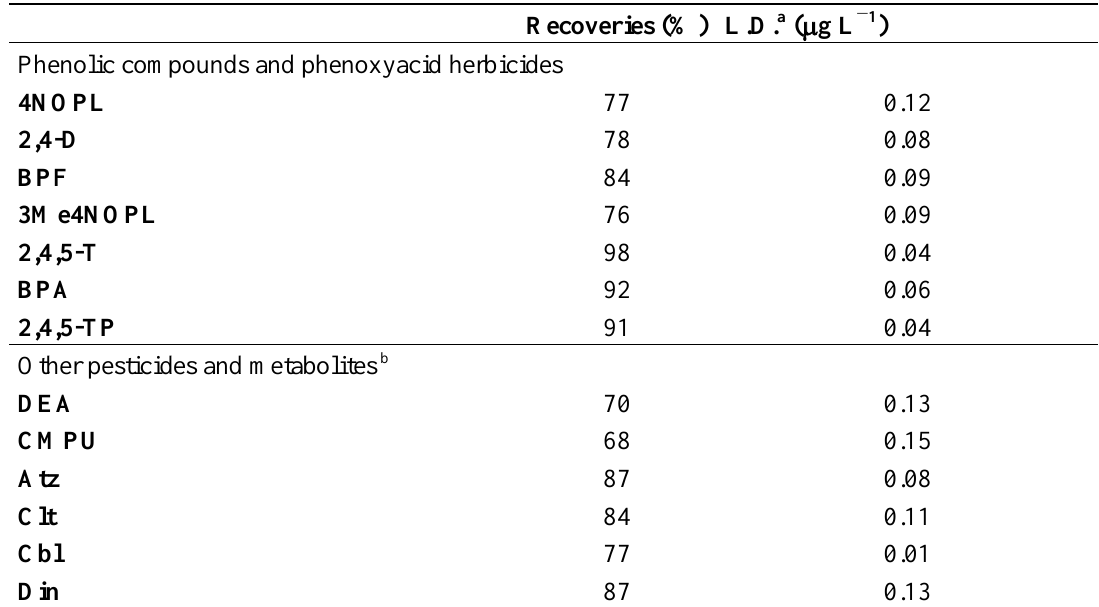
a D.L. = detection limit for a signal-to-noise ratio of 3; b non-retained compounds detected in the washing